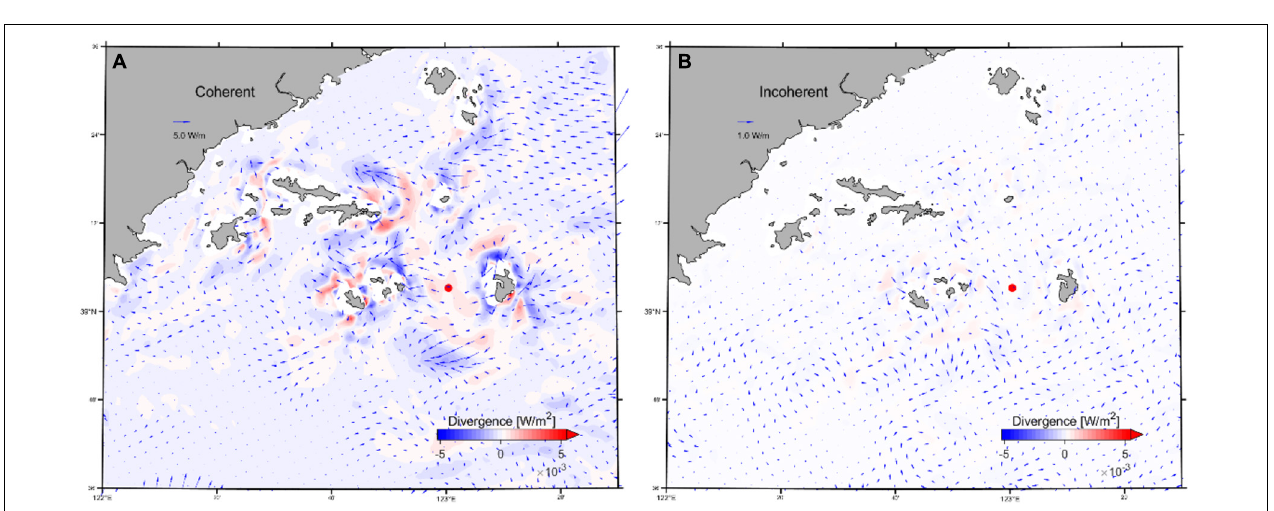
FIGURE 12 | (A) The depth-integrated baroclinic energy flux (W/m) for the M2 semi-diurnal internal tide in the northern Yellow Sea averaged from July 26 to August 10, 2017. (B) Detailed view of the baroclinic energy flux near Changshan islands, with the ADCP mooring location shown as the red dot.